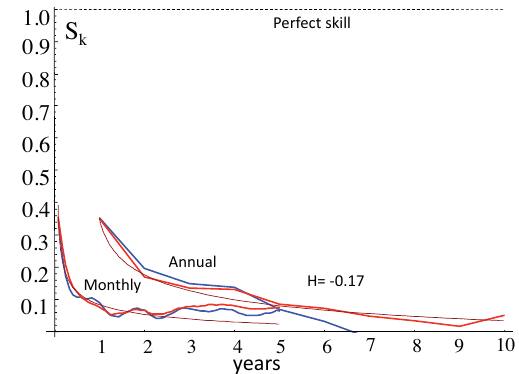
Figure 8. The forecast skill for the temperature at fixed resolutions (one month, bottom left; 1 year, upper right) for global (red) and Northern Hemisphere (blue) series. Also shown are the exact theo- retical curves (for H =− 0.17) that take into account the finite mem- ories of the forecasts (20 and 15 years for the annual and monthly series respectively). The raw curves were shifted a little upward so that their long-time parts were close to the theory; this is equivalent to using the theory to improve the estimate of the ensemble-average skill from the single series that were available.